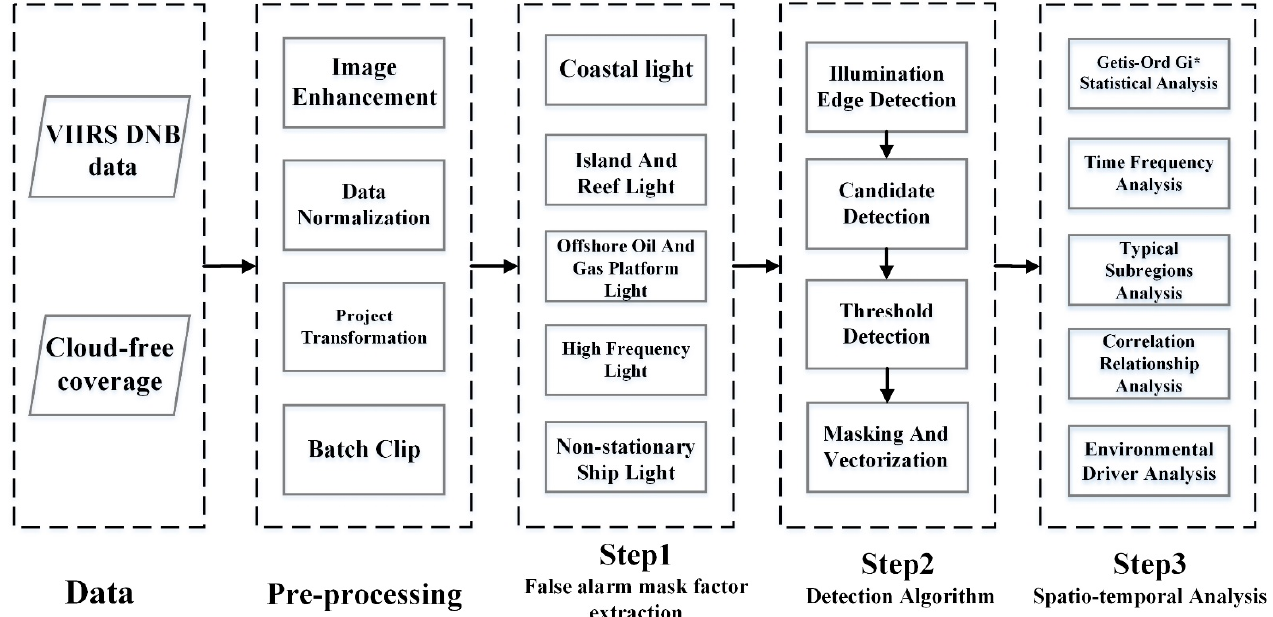
Figure 3. Framework of the methodology used for fishing dynamic research in the SCS.